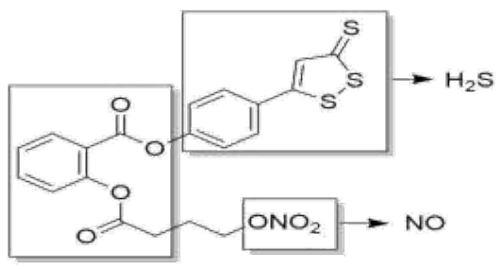
Fig. 4 Structure of NOSH-Aspirin releasing H2S and NO